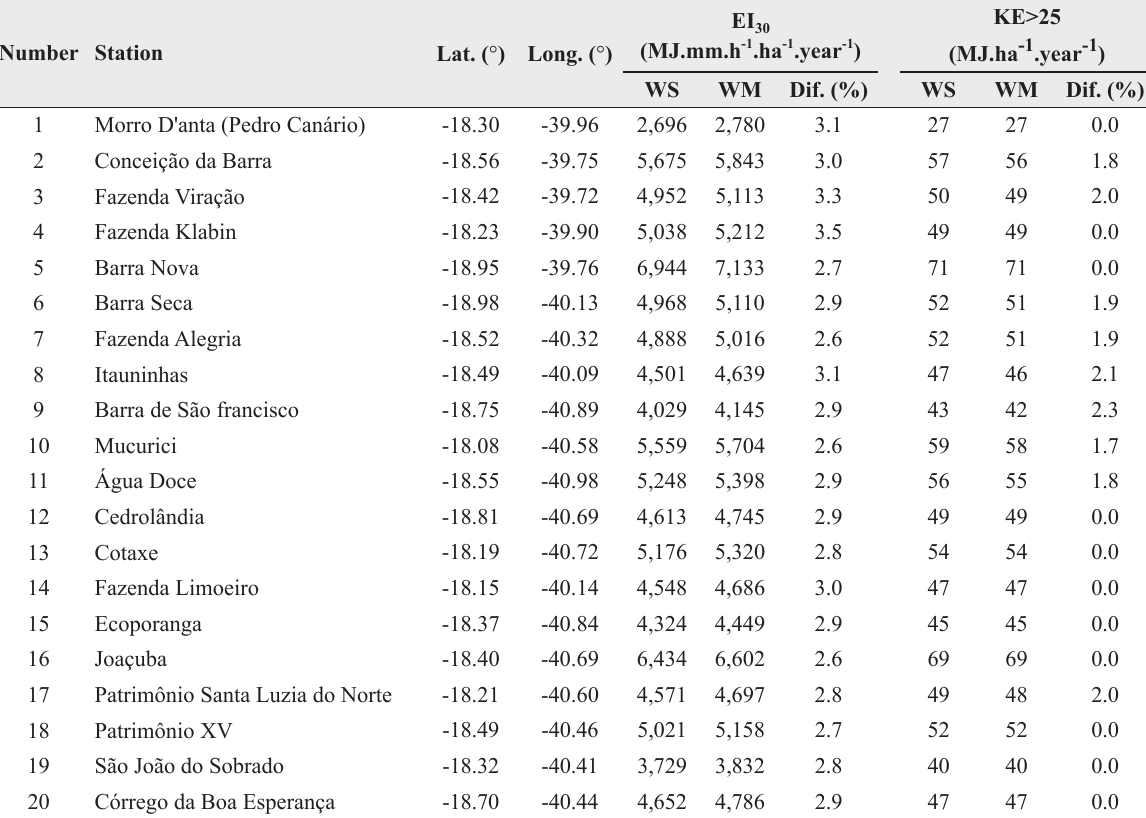
Mean annual rainfall erosivity indices EI energy equations presented by Wischmeier and Smith (1958) (WS) and